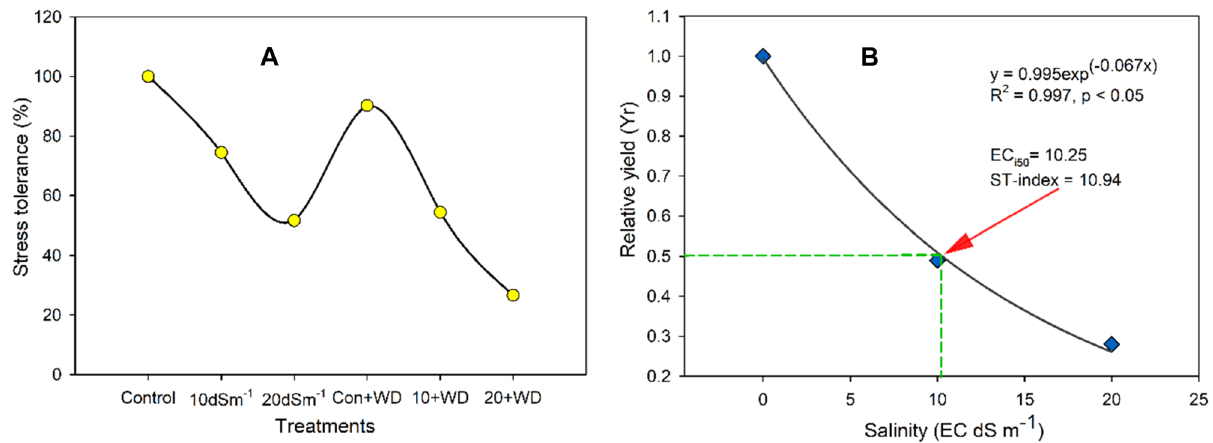
Figure 2. ( A ) stress tolerance (%) and ( B ) Salinity Tolerance Index (STI), Relative Yield (Yr) was based on the root and shoot dry masses (g) according to Steppuhn et al. The highest K + /Na + ratios (4.55, 2.85, and 14.33) in stem, leaf, and root were noted in the control, while the least K + /Na + average values were found in 20 dS m −1 + water stress. Following the control, water stress showed K + / Na + ratios of 4.22, 1.50, and 2.11 in the stem, leaf, and root, respectively. Nonetheless, a non-significant ( P > 0.05) change in the K + / Na + ratio of the root was observed between 20 dS m −1 , and 10 dS m −1 + water stress (Table 1).